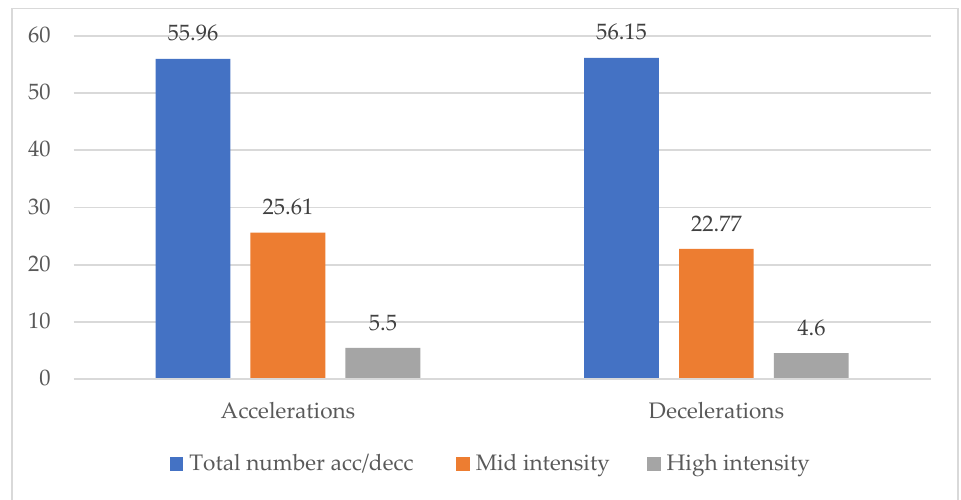
Figure 2. Visualization of acceleration and deceleration intensity distribution. Table 3. Using a T-test for independent samples between groups of ball kids on net and back positions, the analyzed variables are meters covered per minute on court, total decelerations per minute on court, walking and jogging meters per minute (<14.3 km/h) and maximum achieved velocity on court.